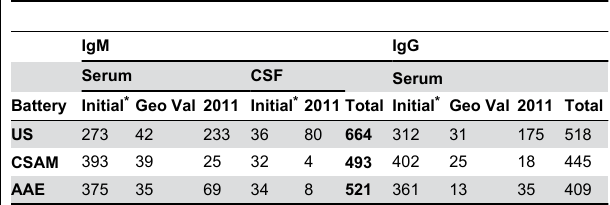
Table 2. Samples tested by IgM and IgG multiplex MIAs listed by geographic